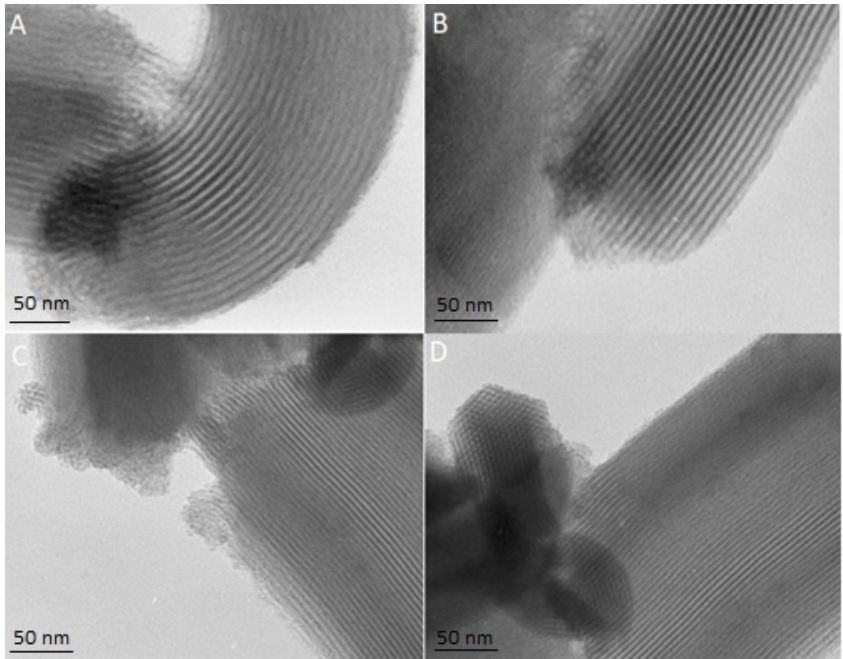
Figure 3. TEM images of ( A ) SBA-15-A 0.05 :SUL, ( B ) SBA-15-A 0.20 :SUL, ( C ) SBA-15-A 0.05, and ( D ) SBA-15-A 0.20 .